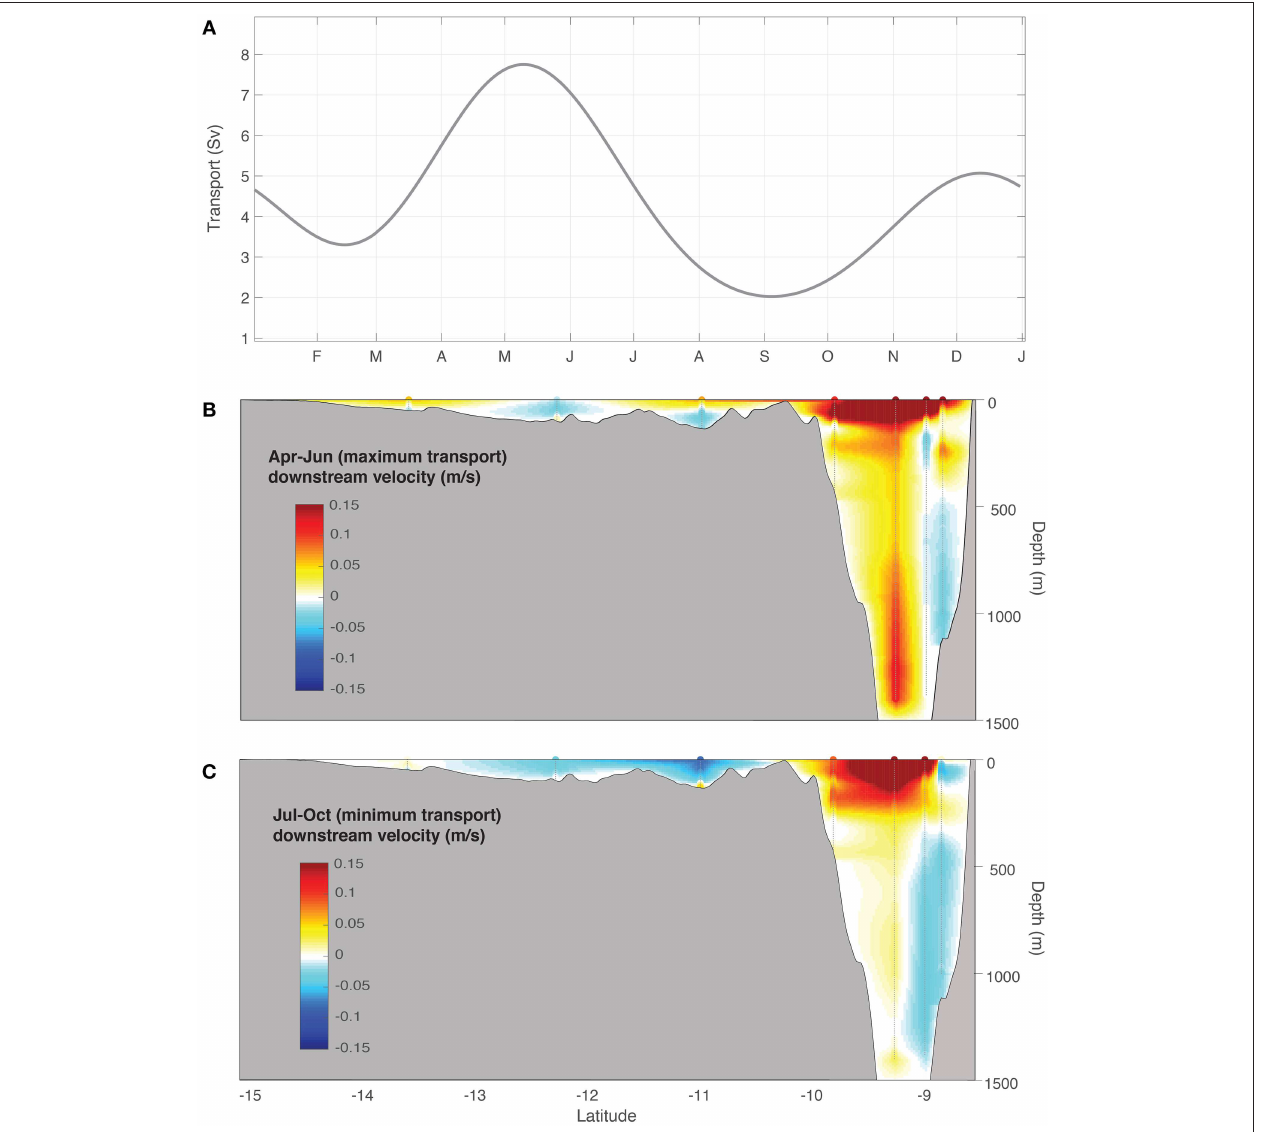
FIGURE 7 | Timor Passage and extension to northern Australian continental shelf IMOS moorings (2011–2015) (A) seasonal transport (Sv), mean velocity (m/s) section for (B) April–June and (C) July–October. April–June corresponds to maximum net transport and July–October to minimum net transport. Vertical lines indicate the position of the moorings.